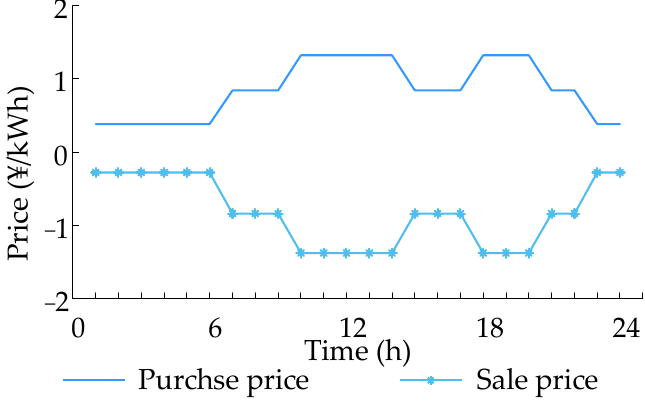
Figure 6. Time-of-use electricity price. Table 1. Parameters of candidate conversion equipment in DES 0.